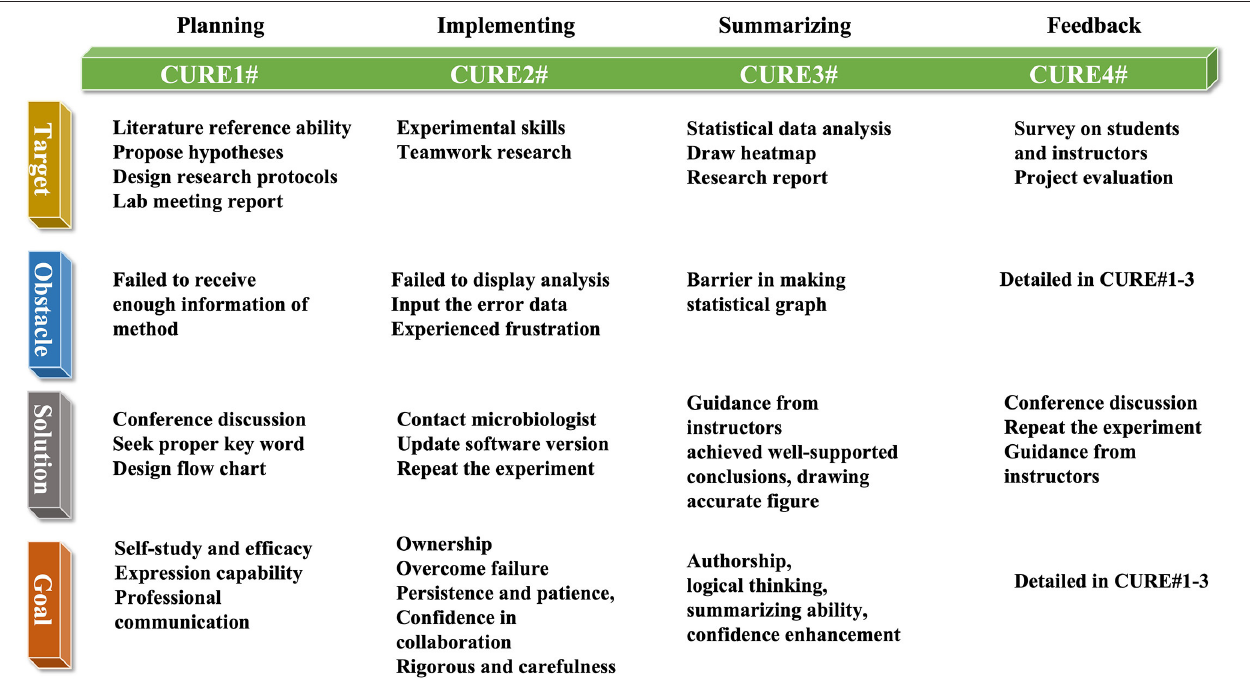
FIGURE 2 | Framework in target, obstacle, solution, and goal of CUREs students reach.